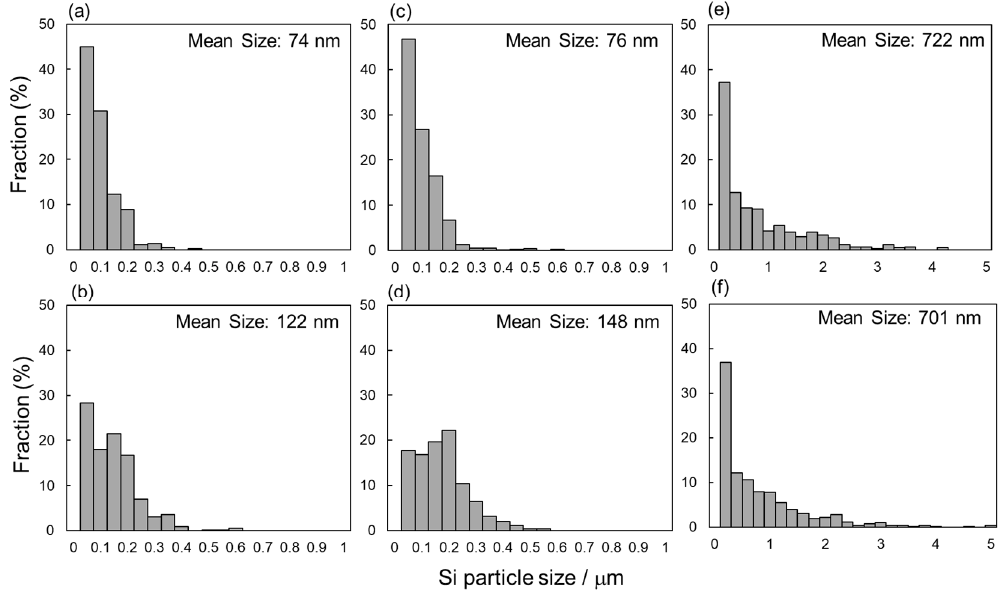
Figure 6. Si particle size distribution measured from the node portion of the lattice specimen with different vertical distances from the geometric center: ( a , c , e ) d N = 0.8 mm, ( b , d , f ) d N = − 0.8 mm; ( a , b ) as-manufactured, ( c , d ) annealed at 300 ° C for 2 h, and ( e , f ) solution heat treated at 530 ° C for 6 h.